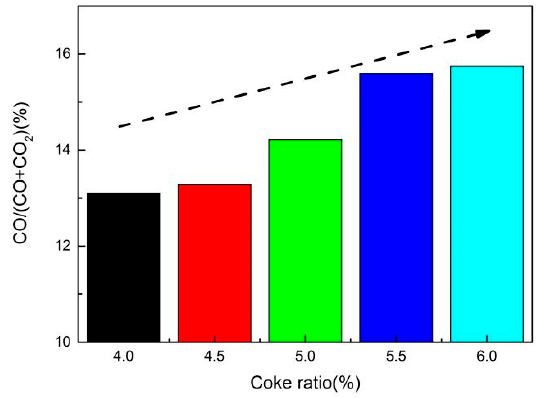
Figure 2. Combustion ratio of flue gas with different coke ratios.